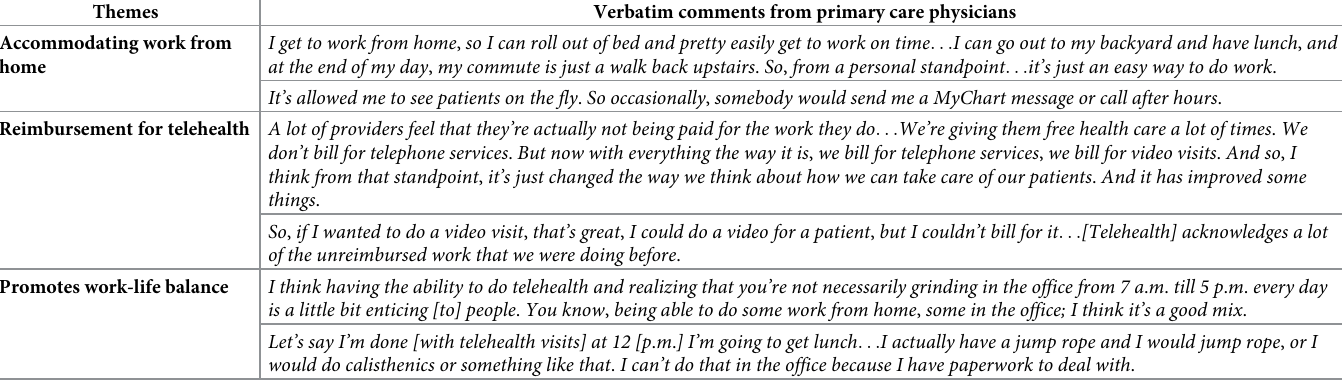
Table 2. Advantages of telehealth for primary care